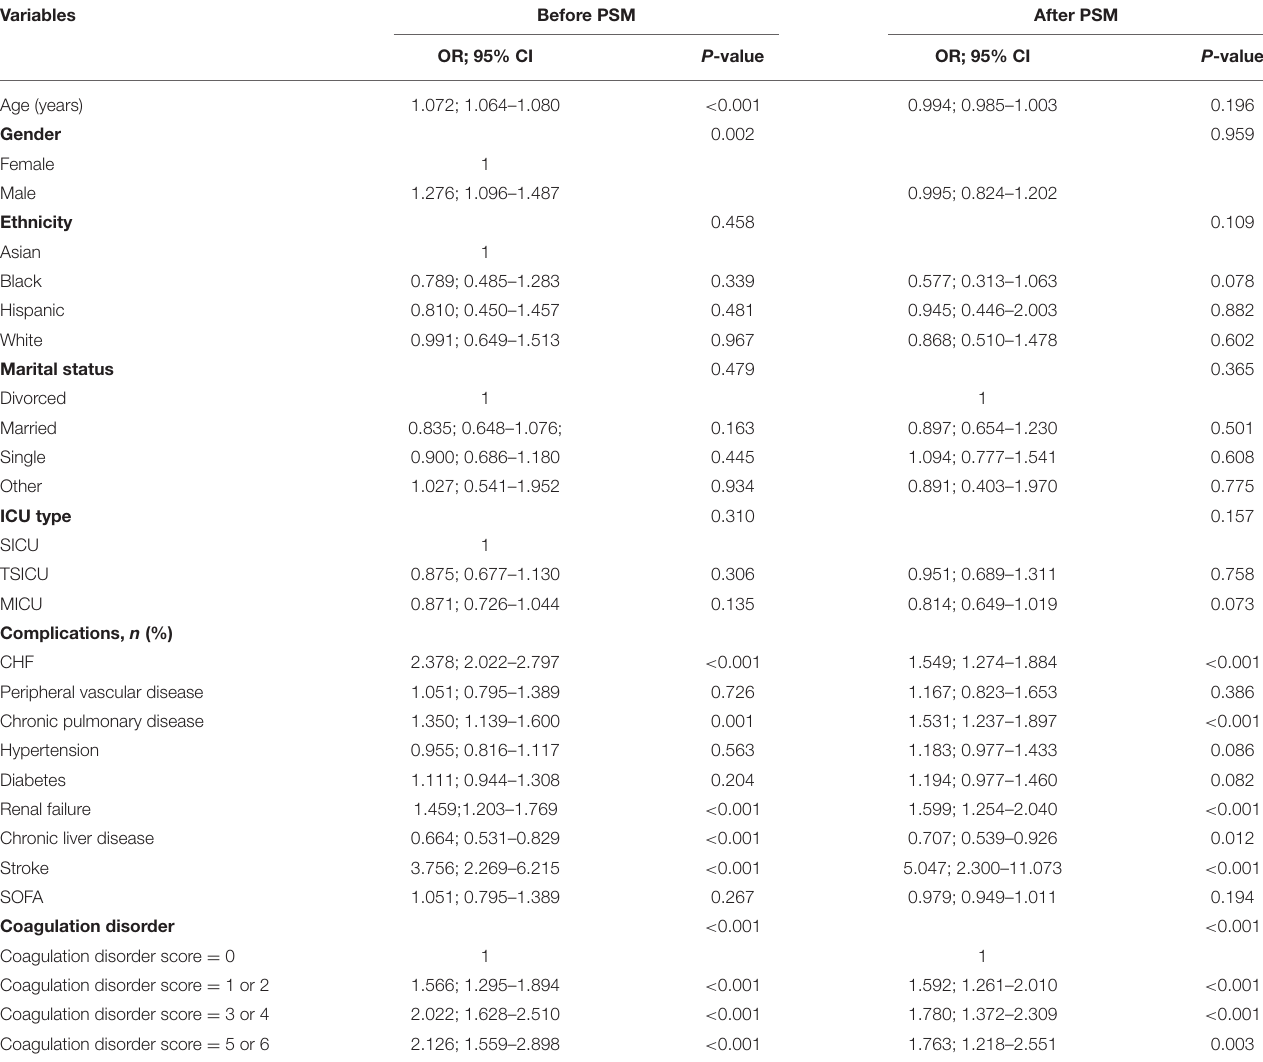
TABLE 3 | Association between early coagulation disorder and AF in multivariate logistic regression before and after PSM. Variables Before